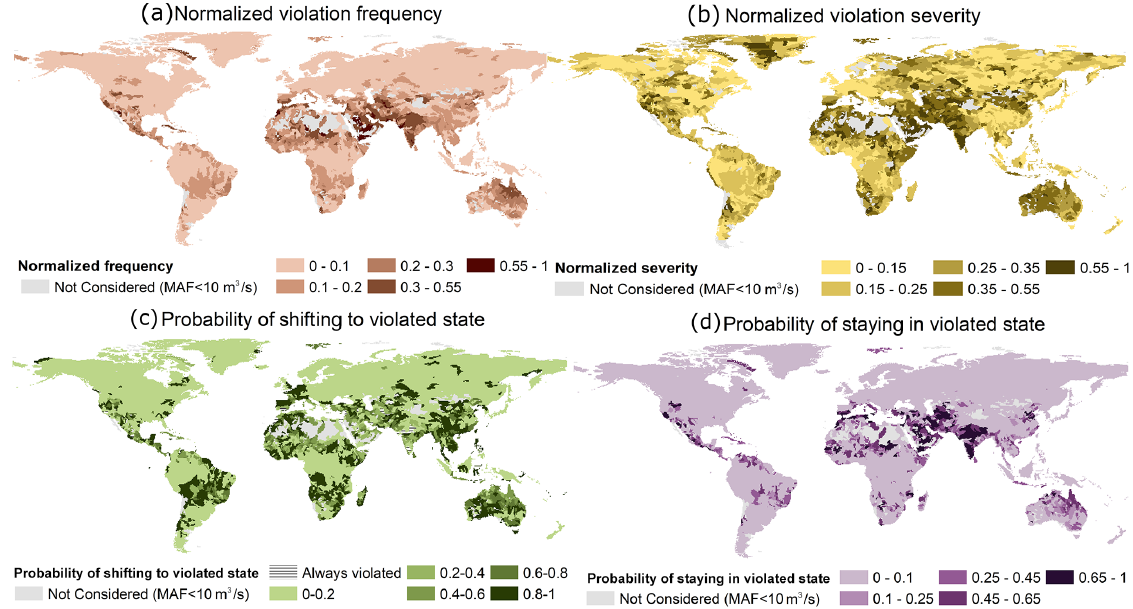
Figure 2. Four measures of environmental flow envelope (EFE) lower or upper bound violation estimated using the ensemble median of four global hydrological models: (a) normalized frequency of violation, (b) normalized severity of violation, (c) probability of shifting to a violated state from a non-violated state, and (d) probability of staying violated once shifted to a violated state.